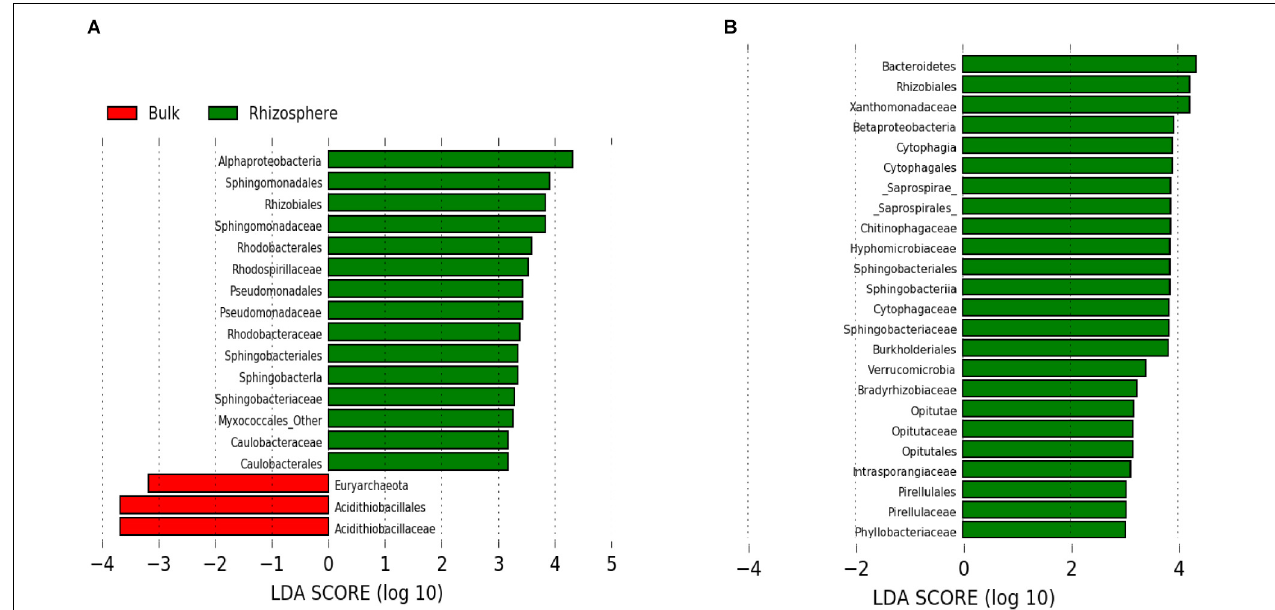
FIGURE 3 | Microbial groups that show enrichment in the rhizosphere (green) or in the bulk (red) based on LEfSe results at (A) high pH ( > 4) ( p < 0.05) and (B) low pH ( < 4) ( p < 0.005). LDA threshold was set to